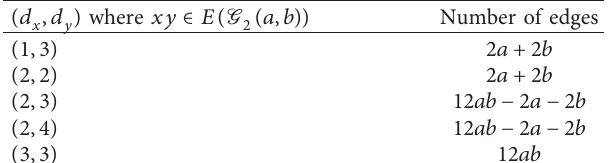
Table 4: The partition of edge set of graph G ( a,b ) based on 2 degrees of neighbor vertices of end vertices of each